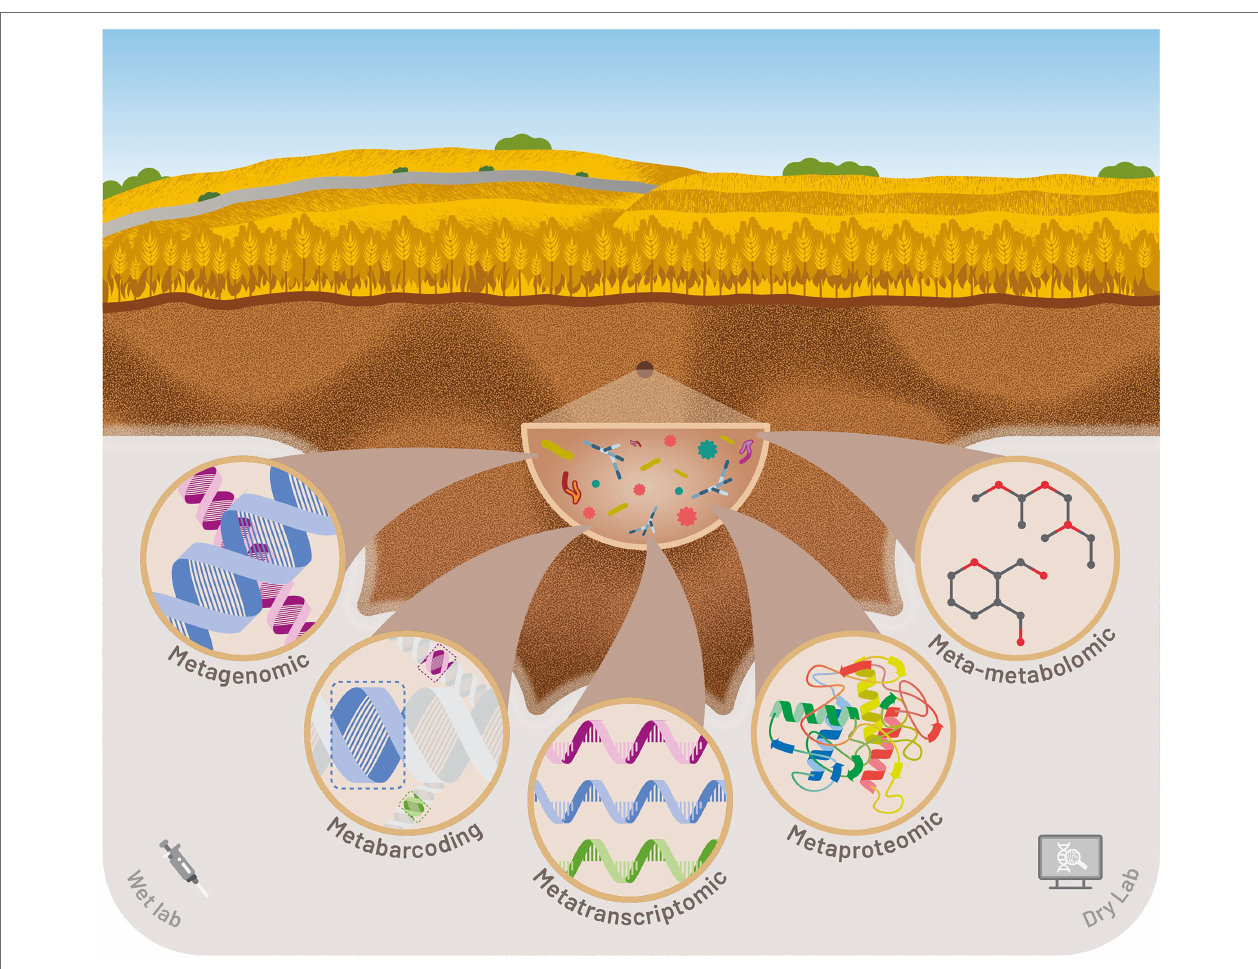
FIGURE 3 | Illustration of various meta-omics approaches for monitoring soil quality and securing food